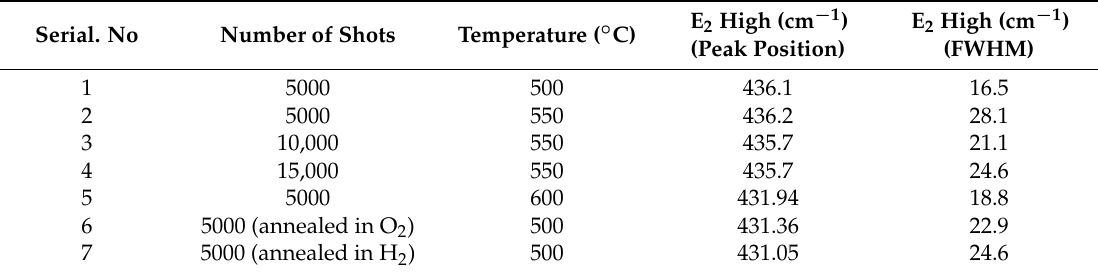
Figure 4. A 1 (LO) mode in Raman spectra of aligned ZnO nanorods at ( a ) 500 ◦ C ( b ) 550 ◦ C and E 2 high mode of aligned ZnO nanorods grown at 500 ◦ C, annealed in ( c ) O 2 atmosphere ( d ) H 2 atmosphere. Table 3. Raman peak E 2 high mode positions of VAZO nanorods.